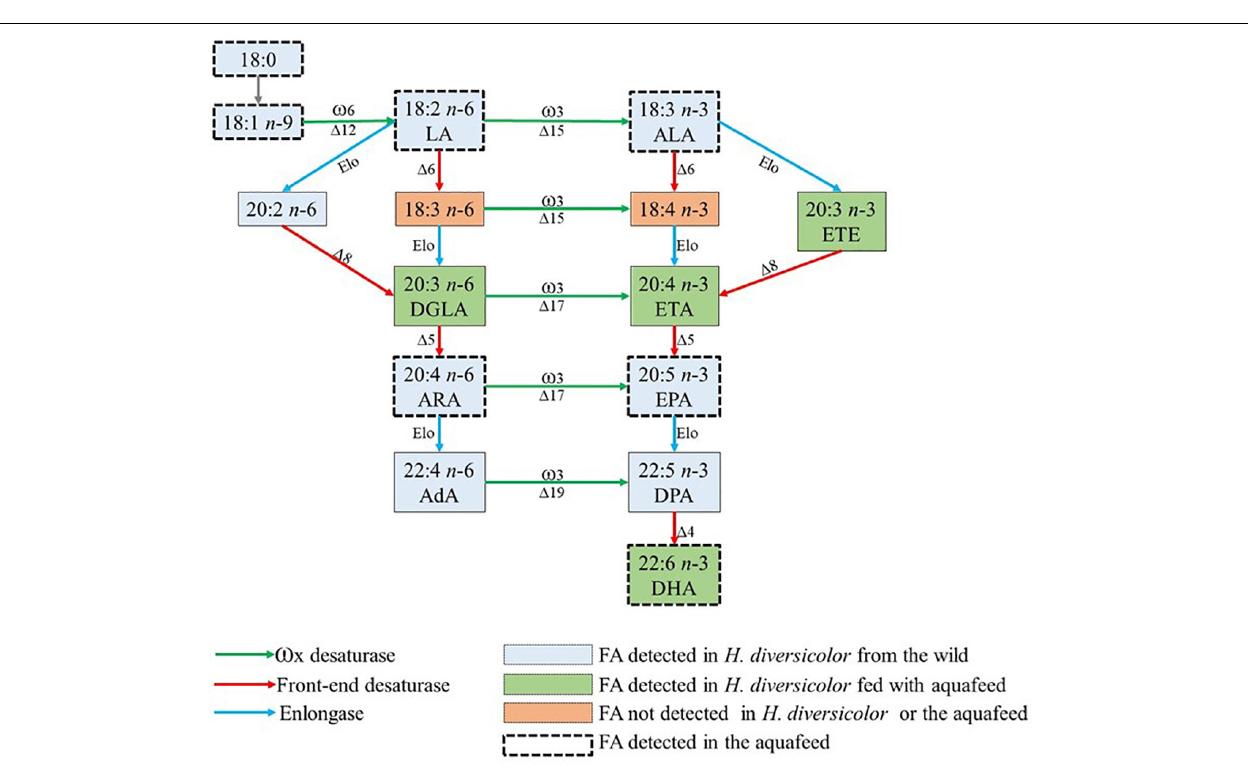
FIGURE 7 | Schematic representation of putative biosynthetic pathways of some polyunsaturated fatty acids (PUFA) identified in Hediste diversicolor from the wild and after being fed on a commercial aquafeed for 40 days. Methyl-end desaturases ( ω , green arrows); Front-end desaturases (red arrows); Elongation reactions (Elo, blue arrows). The “ (cid:49) ” refers to the carbon position at which the incipient double bound (unsaturation) locates within the methyl and front ends of fatty acyl chains. AdA, adrenic acid; ALA, α -linolenic acid; ARA, arachidonic acid; DGLA, dihomo-gamma-linolenic acid; DHA, docosahexaenoic acid; DPA, Docosapentaenoic acid; EPA, eicosapentaenoic acid; ETA, eicosatetraenoic acid; ETE, eicosatrienoic acid; LA, linoleic acid. Scheme adapted from Monroig and Kabeya